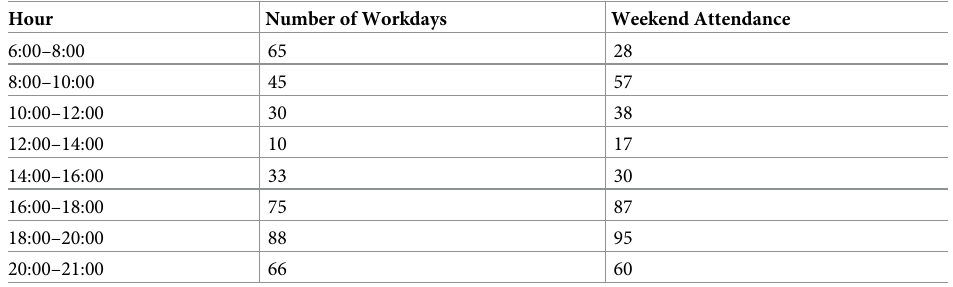
Table 3. Main time periods for outdoor activities during the